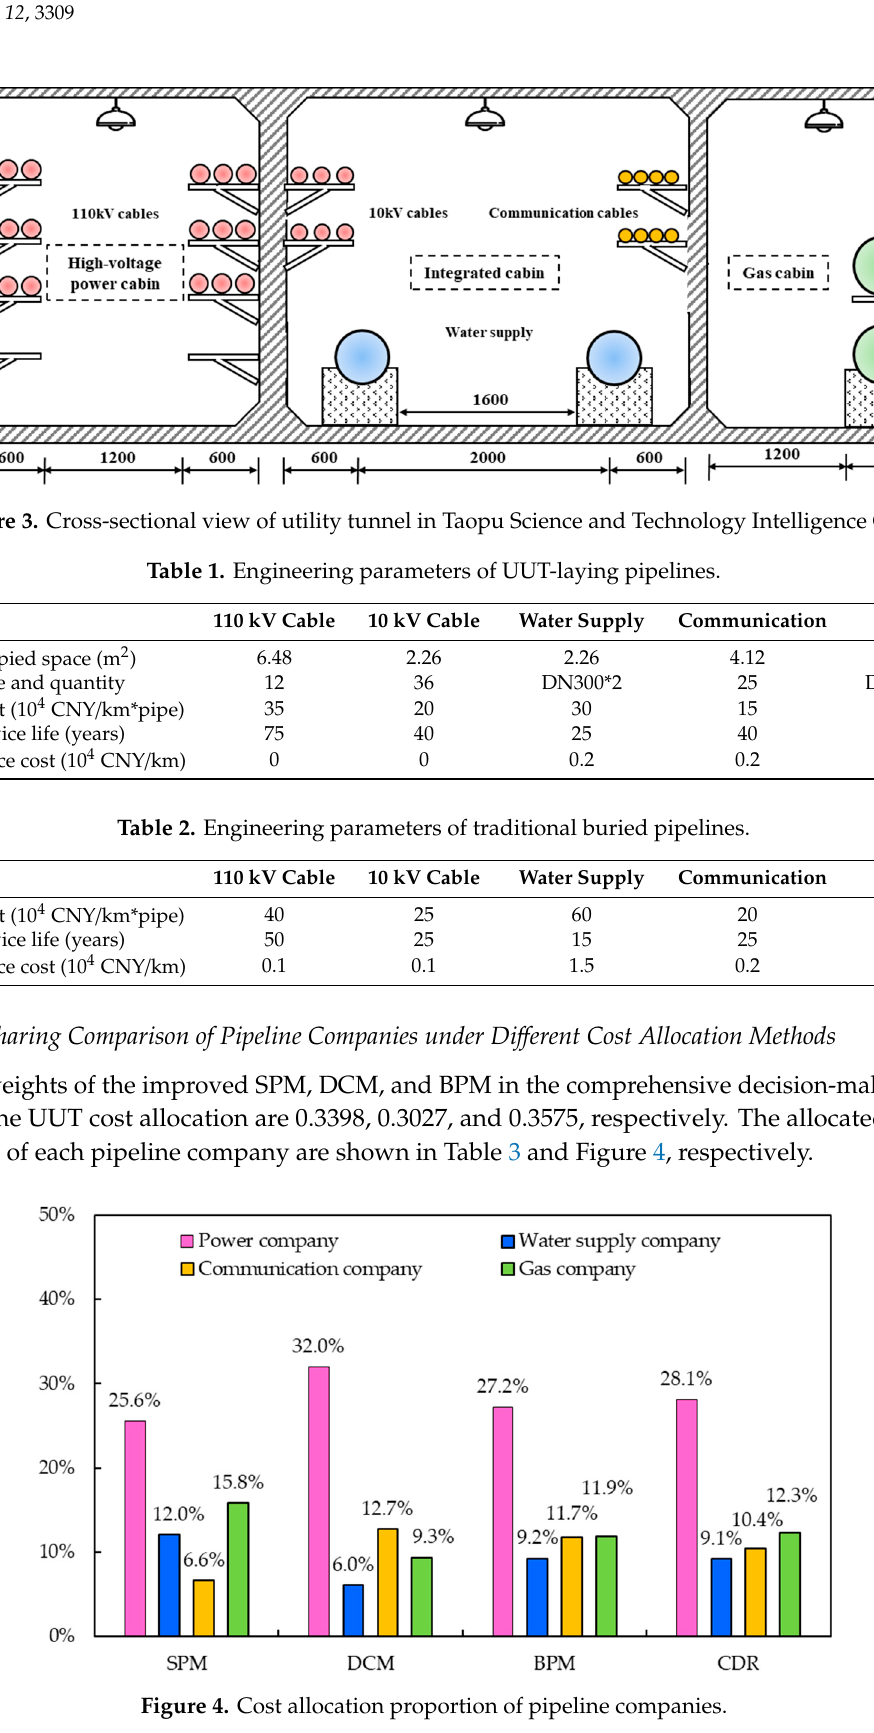
Table 1. Engineering parameters of UUT-laying pipelines.